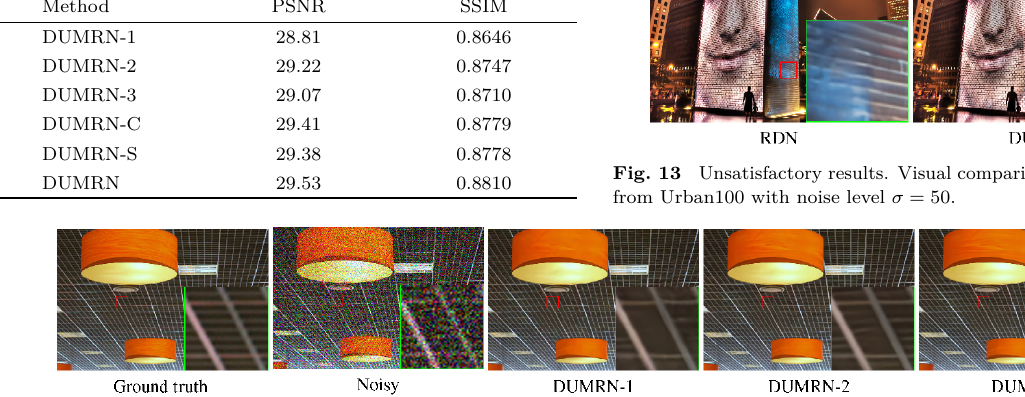
Table 5 Analysis of the proposed MSRB. PSNR (dB) and SSIM results of color image denoising are evaluated on the Urban100 dataset with noise level σ = 50 Method PSNR SSIM